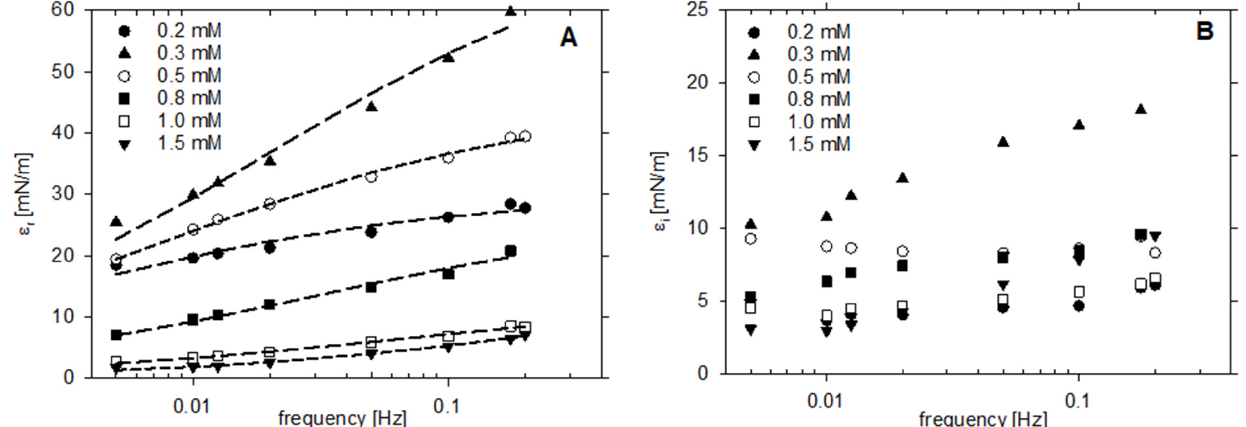
Figure 6. The dependence of ( A ) real, and ( B ) imaginary, parts of the dilational elasticity modulus on the drop surface oscillation frequency for various concentrations of LAE solutions. Dashed lines: fits of the Lucassen-van den Tempel diffusional adsorption model. Table 4. Best fit parameters of the Lucassen-van der Tempel model to the real part of surface dilational elasticity modulus of LAE